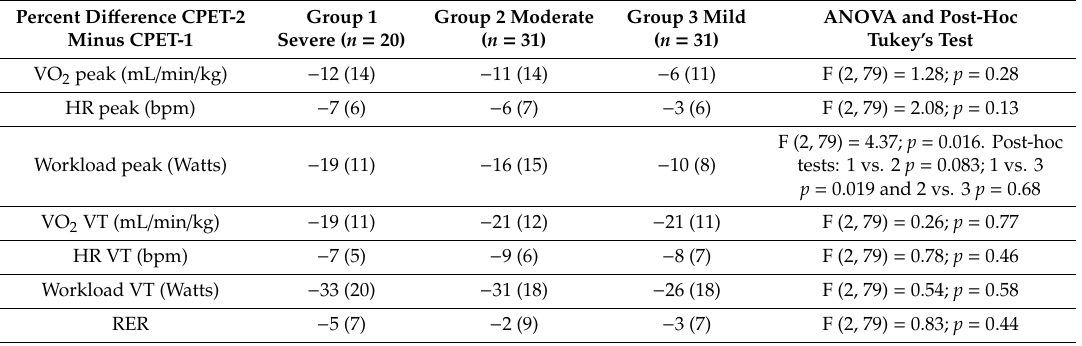
Table 3. Percent di ff erences from CPET-2 minus CPET-1 comparing female ME / CFS patients with severe, moderate and mild disease